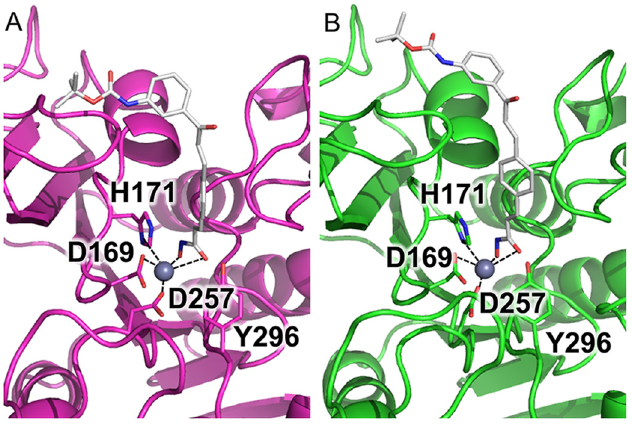
Fig 5. Compound MC2780 docked to the KDAC1 protein. A) in the B . malayi protein and B) in the H . sapiens protein. MC2780 is shown as grey stick model along with important residues for ligand